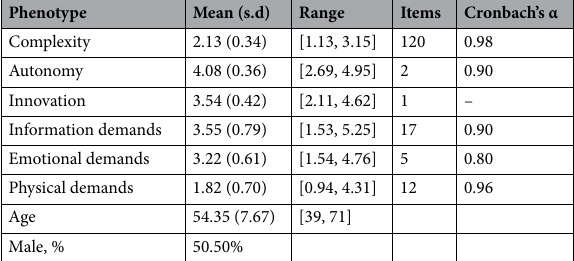
Table 1. Summary of O*NET linked phenotype scores of six job attainment characteristics in the UK Biobank data (N = 219,483). No Cronbach’s α was calculated for innovation as only one item is